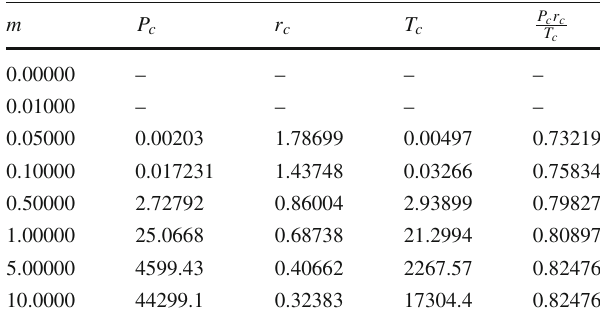
Table 4 Spherical black holes: k = 1, d = 7, q = 1, c 0 = c 1 = c 2 = c 3 = c 4 = 1 and α = 1